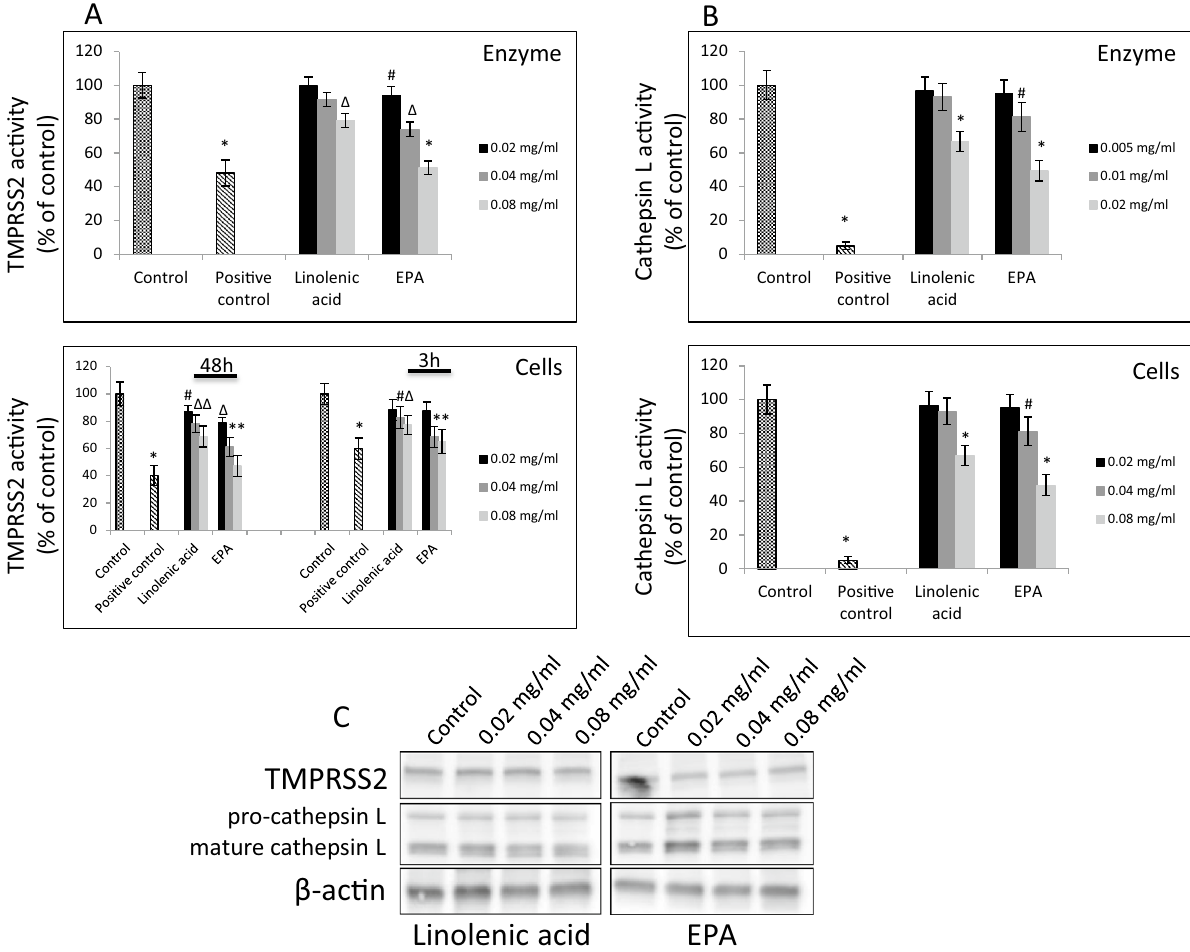
Figure 6. Effect of selected FAs on TMPRSS2 and Cathepsin L proteases. ( A ) Purified TMPRSS2 enzyme at 1 µM was incubated with selected FAs at different concentrations for 1 h at RT followed by addition of fluorogenic substrate at 10 µM concentration for 30 min. Fluorescence signal was measured at Ex/ Em = 360/440 nm using spectrofluorimeter (upper panel). A549 cells were treated with indicated FAs at different concentrations for 3 h and 48 h at 37 °C and enzymatic activity was measured by addition of 0.2 mM fluorogenic substrate and incubation for 30 min. at 37 °C. Fluorescence signal was measured at Ex/ Em = 360/440 nm using spectrofluorimeter (lower panel). Data are presented as % of control ± SD; # p ≤ 0.05, ∆ p ≤ 0.01, * p ≤ 0.001. Control—0.025% DMSO, positive control—50–100 μM camostat mesylate. ( B ) Purified cathepsin L enzyme at 0.02 ng/µl was incubated with selected FAs at different concentrations for 1 h at RT followed by addition of fluorogenic substrate at 10 µM concentration for 30 min. Fluorescence signal was measured at Ex/Em = 360/440 nm using spectrofluorimeter (upper panel). A549 cells were treated with indicated lipids at different concentrations for 24 h at 37 °C and enzymatic activity was measured by addition of 0.2 mM fluorogenic substrate and incubation for 30 min. at 37 °C. Fluorescence signal was measured at Ex/ Em = 360/535 nm using spectrofluorimeter (lower panel). Data are presented as % of control ± SD; # p ≤ 0.05, * p ≤ 0.001. Control—0.025% DMSO, positive control—0.1 μM E-64. ( C ) Western blot analysis of TMPRSS2 and cathepsin L expression in A549 cells treated with indicated FAs with different concentration for 48 h. Detection was done using rabbit anti-TMPRSS2 monoclonal antibody at 1:1000 and mouse anti-cathepsin L antibody at 1:200. Experiments were done in triplicate and repeated three times. Data are presented as % of lipid-free control ±